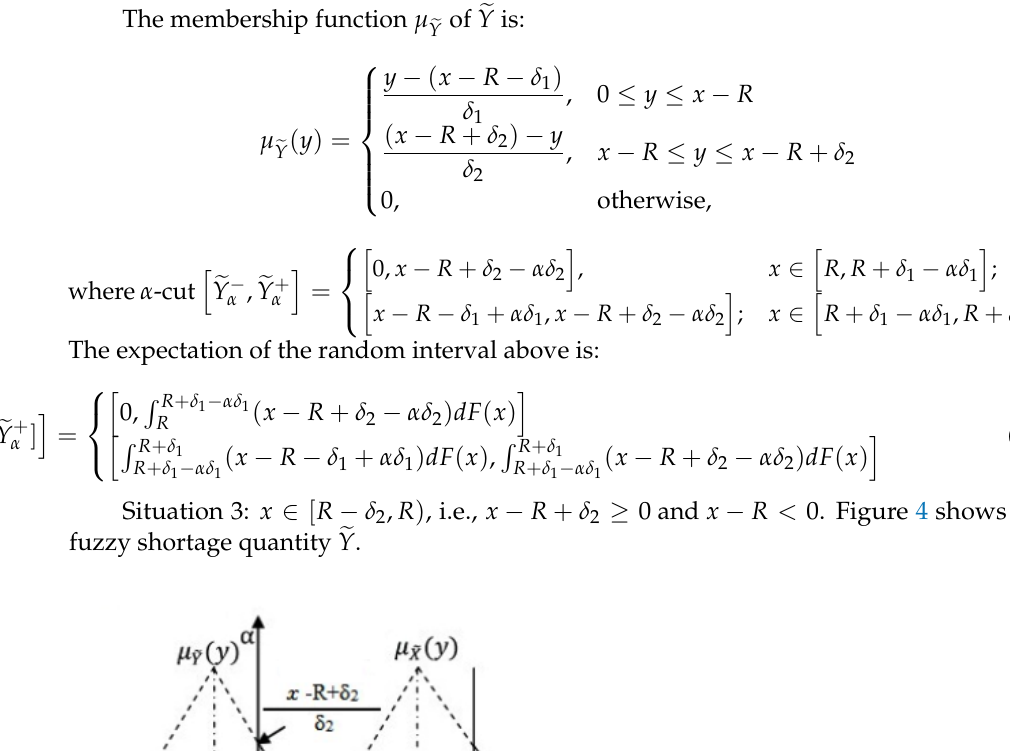
Figure 3. Membership function of the fuzzy shortage quantity when R ≤ x < R + δ 1 .